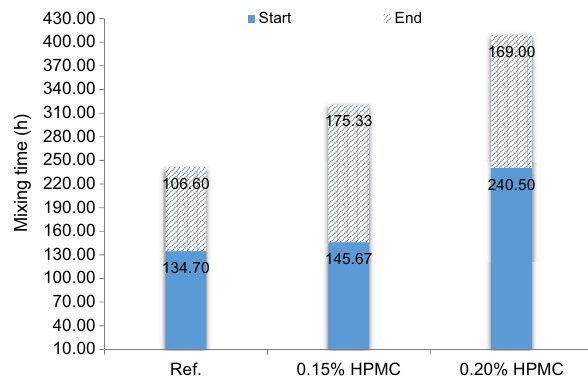
Figure 7: Start and end of setting of mixtures.